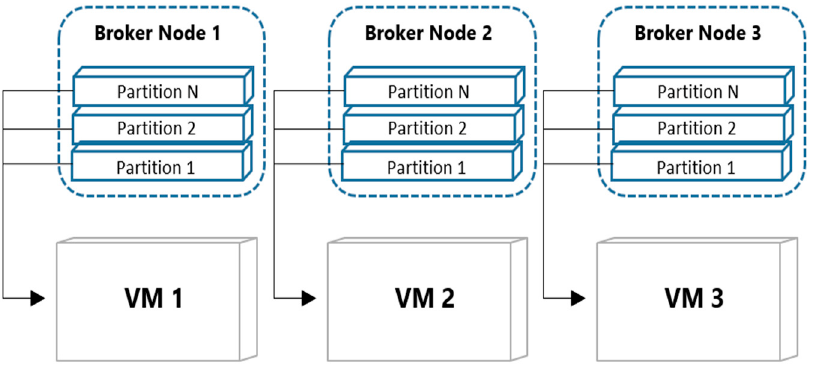
Figure 3. The example case of distributed environment consisting of 3 broker nodes and 3 VMs.